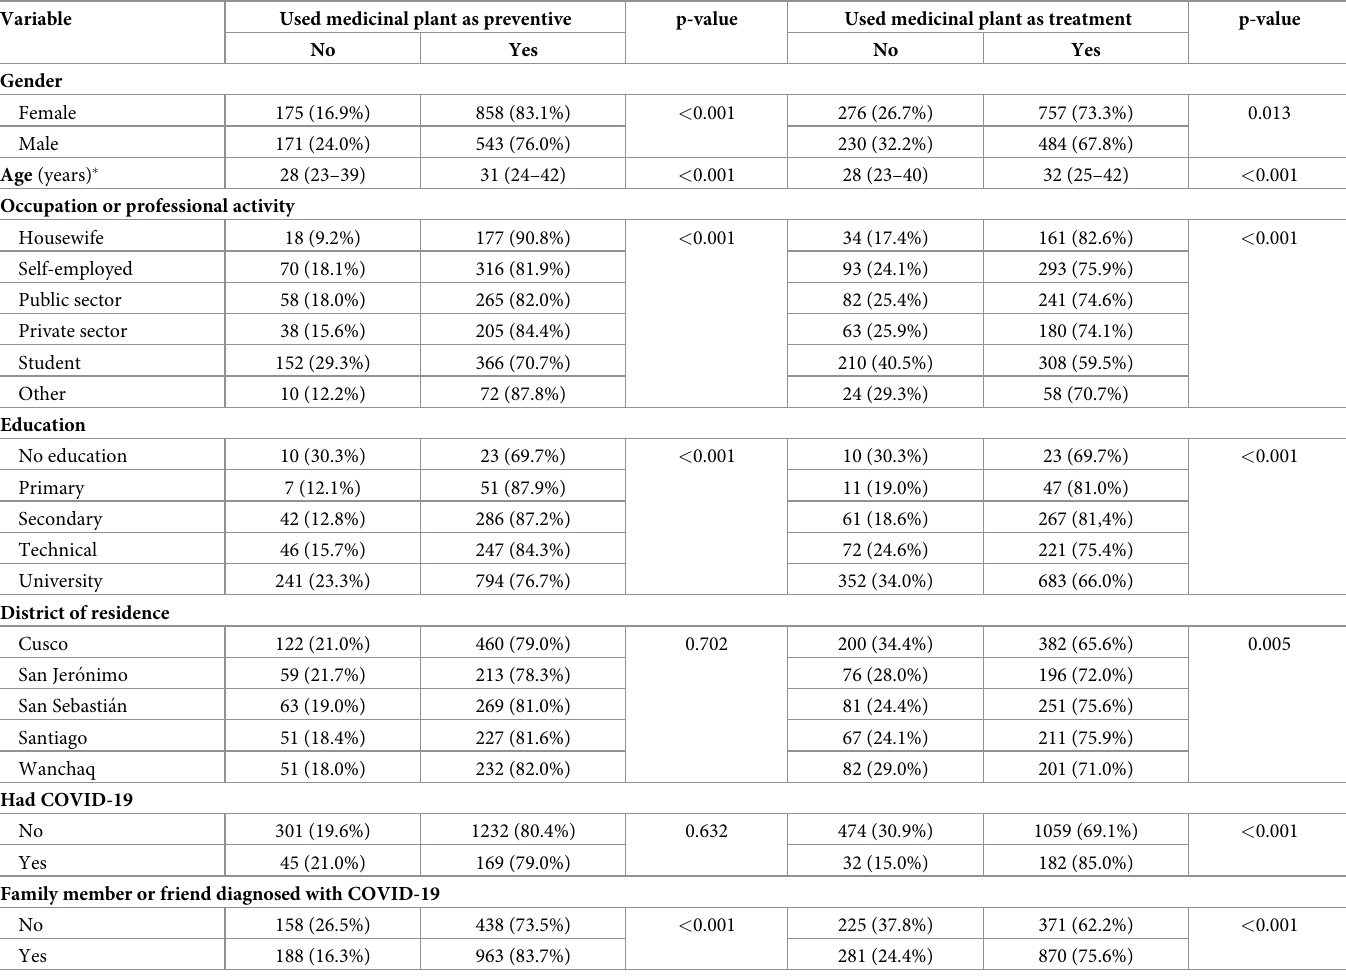
Table 2. Use of medicinal plants as preventive or treatment for respiratory symptoms during the COVID-19 pandemic in Cusco, Peru.